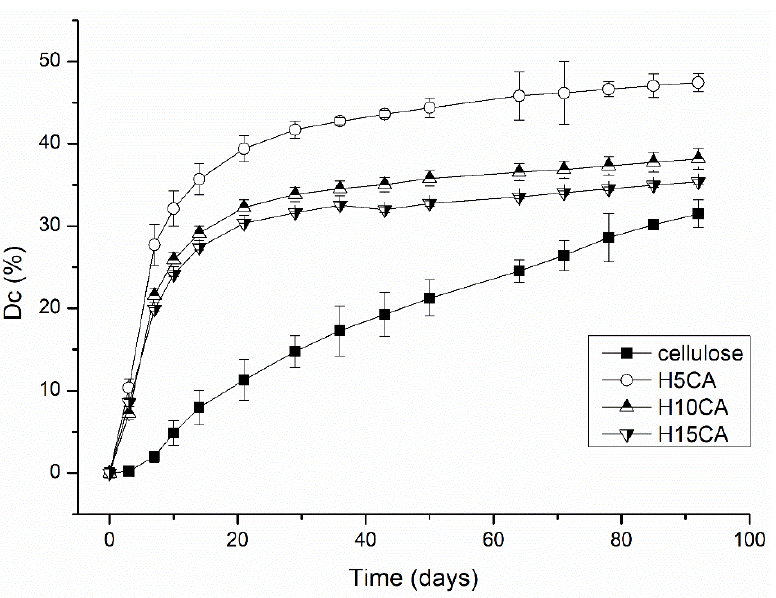
Figure 11. Mineralization curves for the various cross-linked samples, including reference material (cellulose).